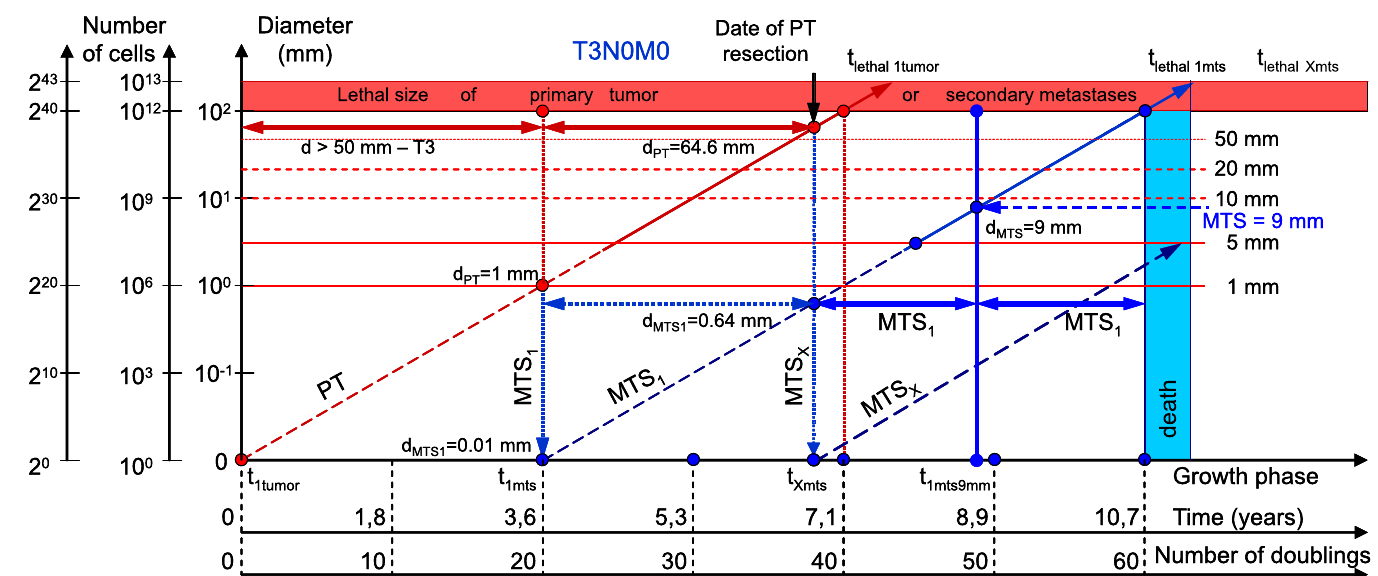
Fig 7. T3N0M0. The whole natural history of PT and secondary distant MTS of patients without lymph nodes MTS via CoMPaS. Parameter T3: d > 50 mm. Diameter of PT at surgery of PT: d PT = 64.6 mm. Diameter of secondary distant MTS at surgery of PT: d MTS = 0.64 mm.